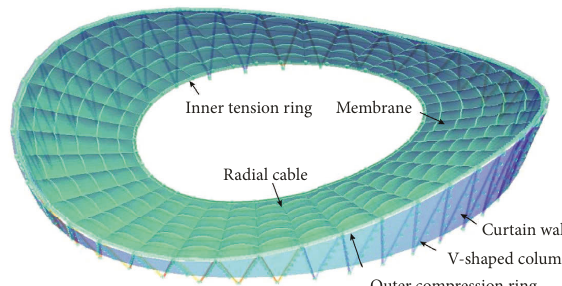
Figure 4: Composition of the main roof structure.